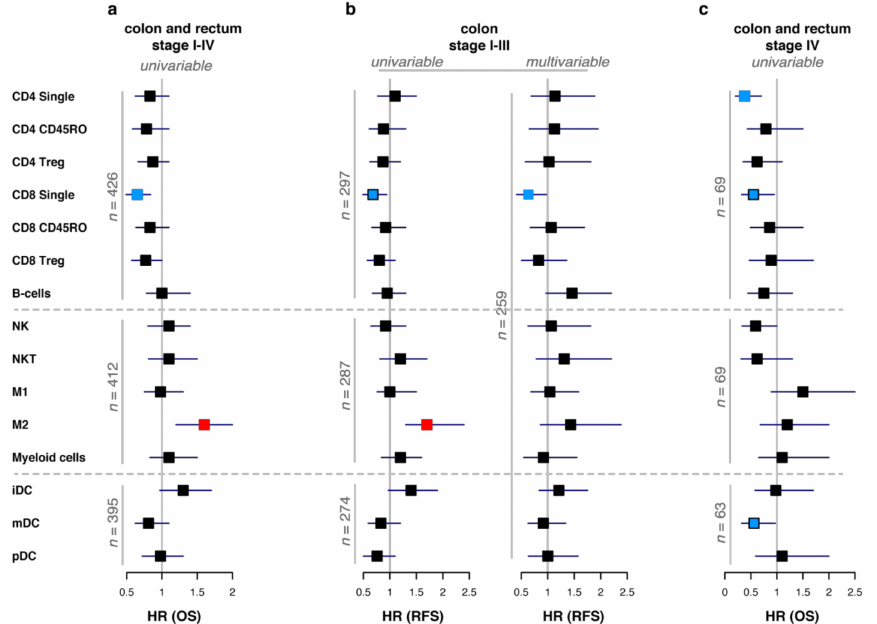
Figure 3. Immune scores predict patient survival. Forest plot of hazard ratios (HR) for immune scores in the univariable and multivariable Cox regression models. Filled squares indicate HR and whiskers represent 95% CI. Blue-colored squares indicate statistically significant ( p < 0.05 and, where applicable, FDR q < 0.05) associations of the respective immune score with improved survival, while red squares represent association with reduced survival. Blue-colored squares with black contour indicate that the association was statistically significant in an individual test ( p < 0.05) but lost statistical significance after adjustment for multiple testing (FDR q ≥ 0.05). ( a ) Univariable associations of immune scores with OS in a complete cohort of therapy-naïve patients. For detailed information see Table S5. ( b ) Association of immune scores with RFS in stage I–III colon cancer. Left panel illustrates the result of the univariable Cox regression models. Right panel illustrates the result of the multivariable Cox regression model, adjusted to clinicopathological parameters: pT, pN stages, tumor differentiation, patient age, surgery type (elective or acute), and adjuvant treatment. For detailed information see Supplementary Tables S6 and S7. ( c ) Univariable associations of immune scores with OS in stage IV therapy-naïve colorectal cancer patients. For detailed information, see Table